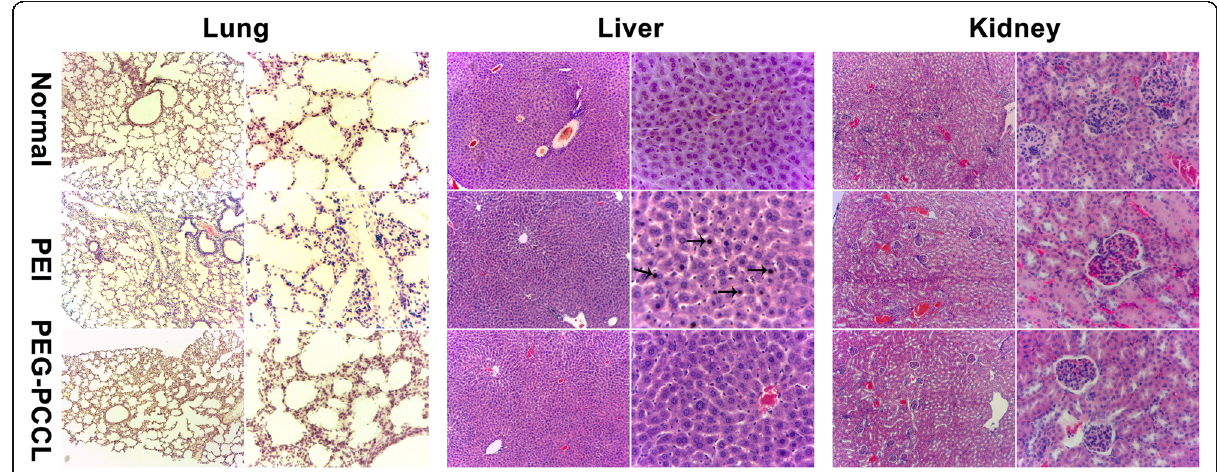
Fig. 8 The H&E dyeing light microscopic images of the lung, liver, and kidney. The images are collected from mice intravenous administrated with NS, PEI, and PEG-PCCL. The needles represent the karyopyknosis of hepatocyte. (Images of left columns, × 10; images of right columns ×